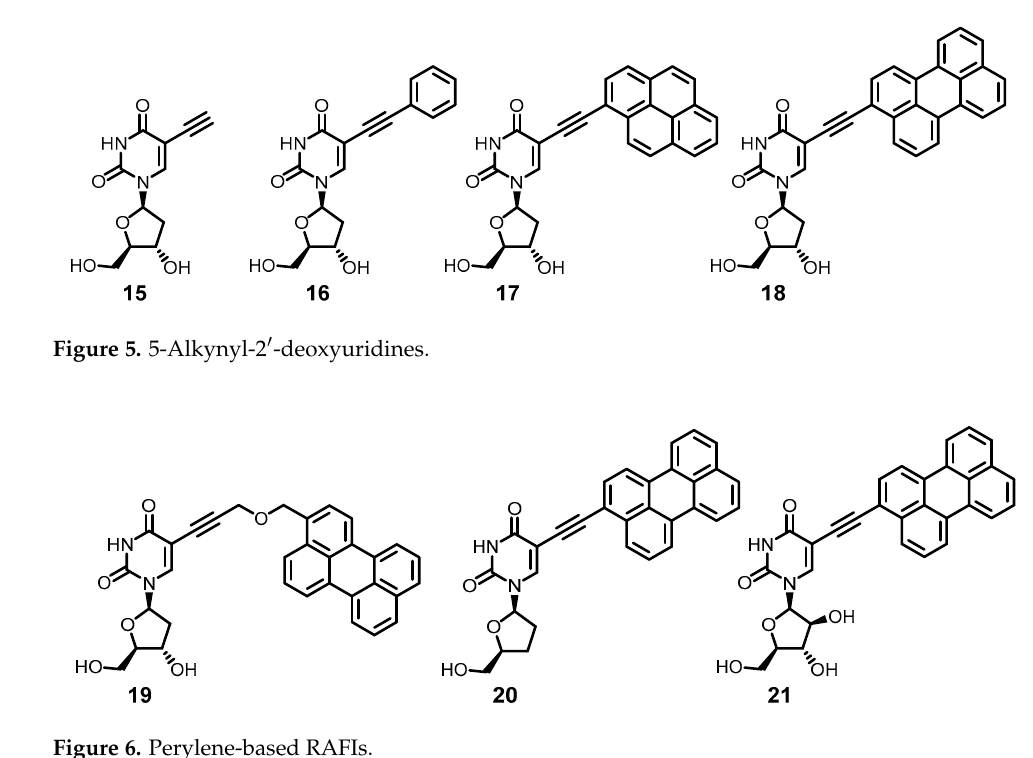
Figure 5. 5-Alkynyl-2 ′ -deoxyuridines.